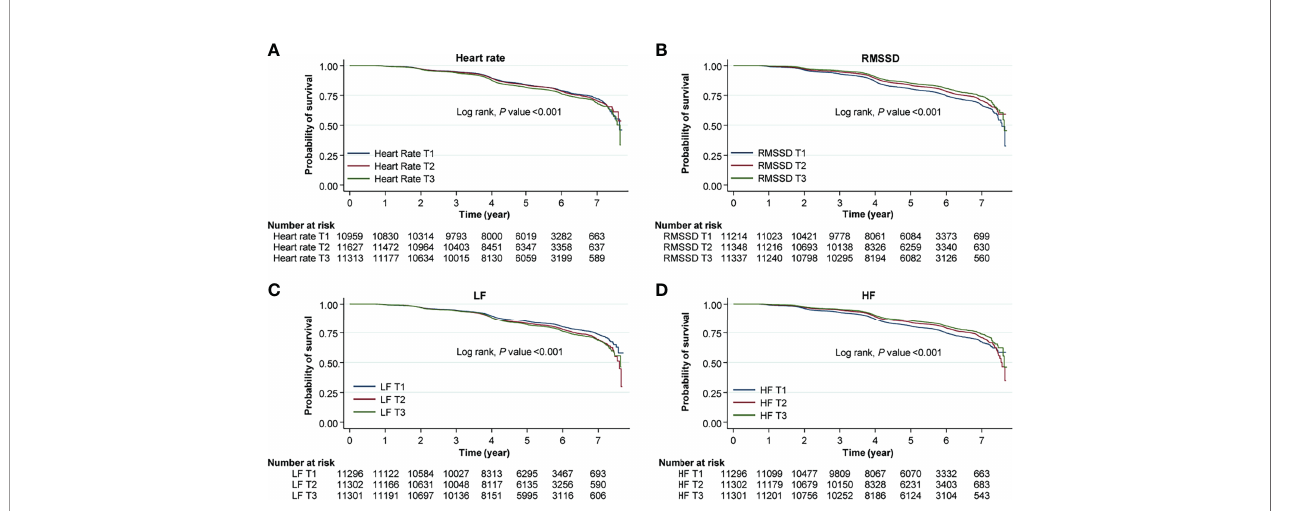
FIGURE 2 | Kaplan – Meier curves for the risk for incident NAFLD according to HRV measurement. Each curves represent the risk for incident NAFLD according to tertiles of (A) heart rate, (B) root mean square difference (RMSSD), (C) low frequency (LF), and (D) high frequency (HF). Original data shown in the is included in supplemental materials ( Supplementary Table 4 ).